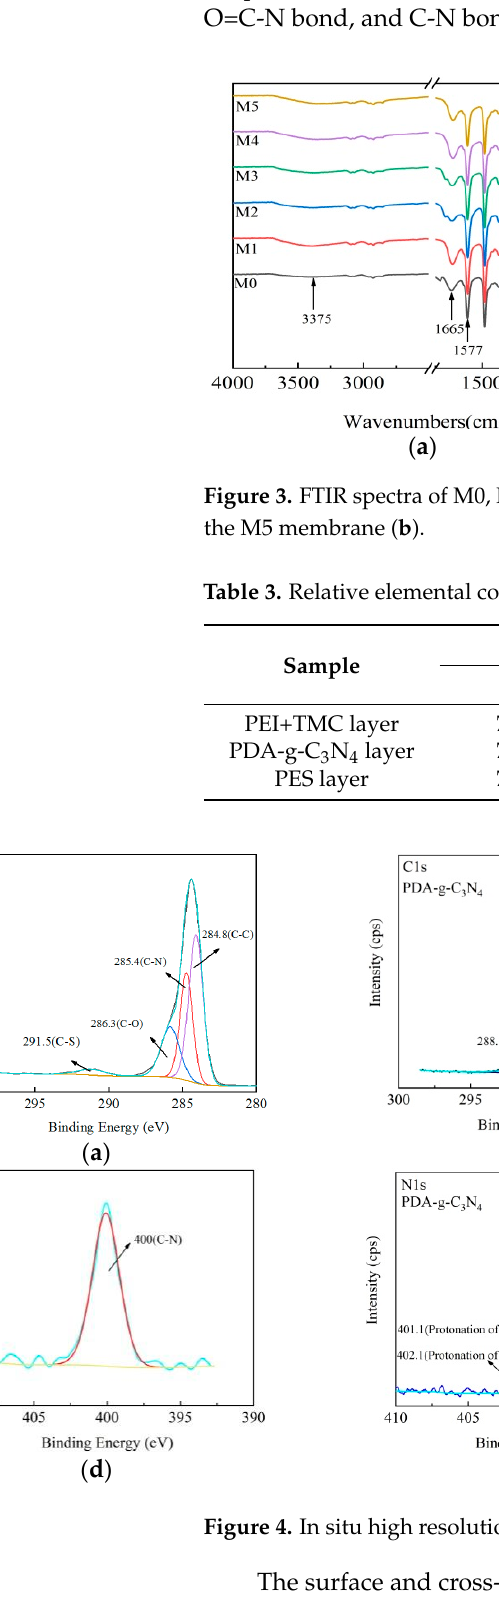
( f ) Figure 5. The surface and cross-sectional SEM images of PES ( a , d ), PES/PDA-g-C 3 N 4 ( b , e ), and M5 ( c , f ) membranes.